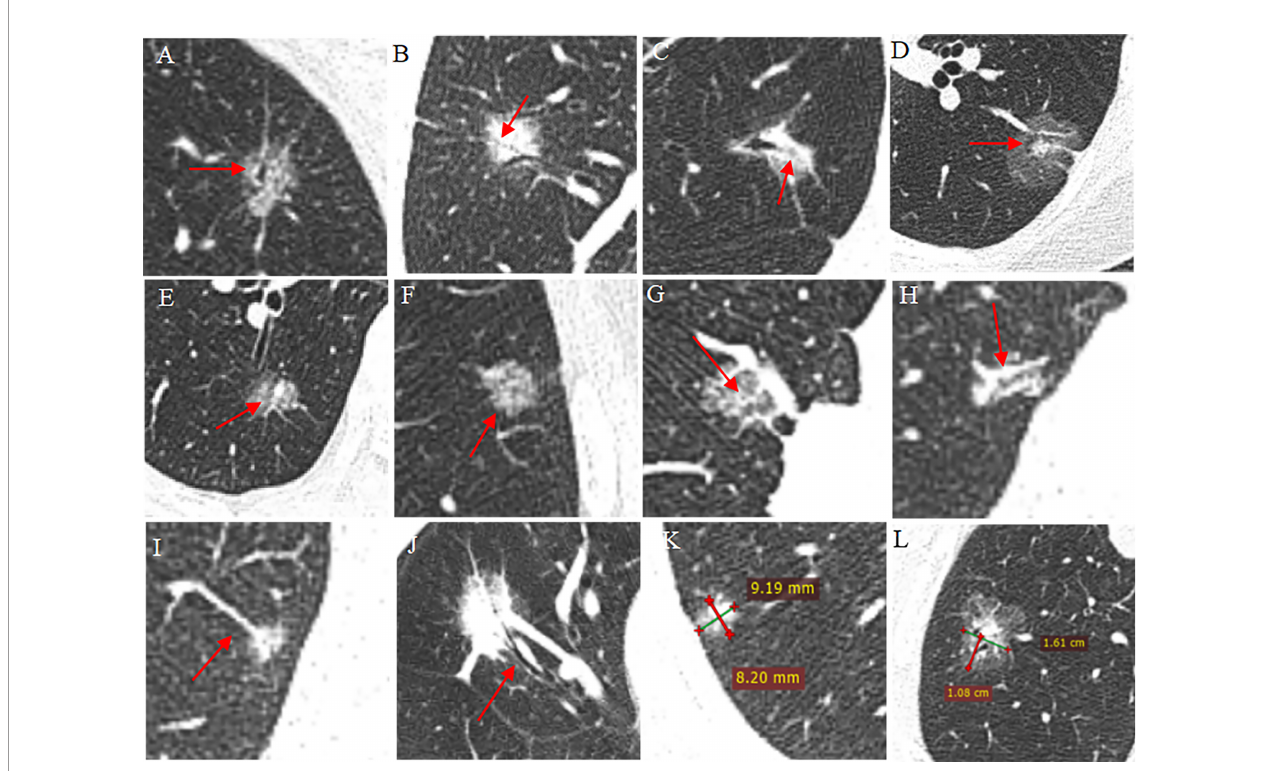
FIGURE 2 | Part of the annotation schematic diagram of CT fi ndings. (A – C) Bronchial sign: dilated (A) , stenosis (B) , interrupt (C) ; (D – F) intra-nodule component: round (D) , big fl ake (E) , small patches (F) ; (G – J) vessel sign: vessel cover sign_abnormal branches (G) , vessel cover sign_enlarged (H) , vessel connected_congestion (I) , convergence sign (J) ; (K, L) quantitative measurement of size (K) and lobulation (L)